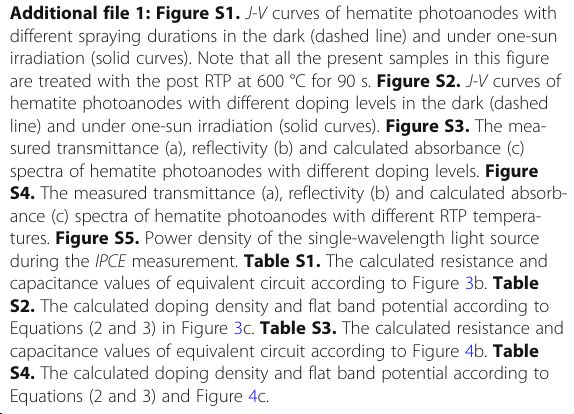
Additional file 1: Figure S1. J-V curves of hematite photoanodes with different spraying durations in the dark (dashed line) and under one-sun irradiation (solid curves). Note that all the present samples in this figure are treated with the post RTP at 600 °C for 90 s. Figure S2. J-V curves of hematite photoanodes with different doping levels in the dark (dashed line) and under one-sun irradiation (solid curves). Figure S3. The mea- sured transmittance (a), reflectivity (b) and calculated absorbance (c) spectra of hematite photoanodes with different doping levels. Figure S4. The measured transmittance (a), reflectivity (b) and calculated absorb- ance (c) spectra of hematite photoanodes with different RTP tempera- tures. Figure S5. Power density of the single-wavelength light source during the IPCE measurement. Table S1. The calculated resistance and capacitance values of equivalent circuit according to Figure 3b. Table S2. The calculated doping density and flat band potential according to Equations (2 and 3) in Figure 3c. Table S3. The calculated resistance and capacitance values of equivalent circuit according to Figure 4b. Table S4. The calculated doping density and flat band potential according to Equations (2 and 3) and Figure